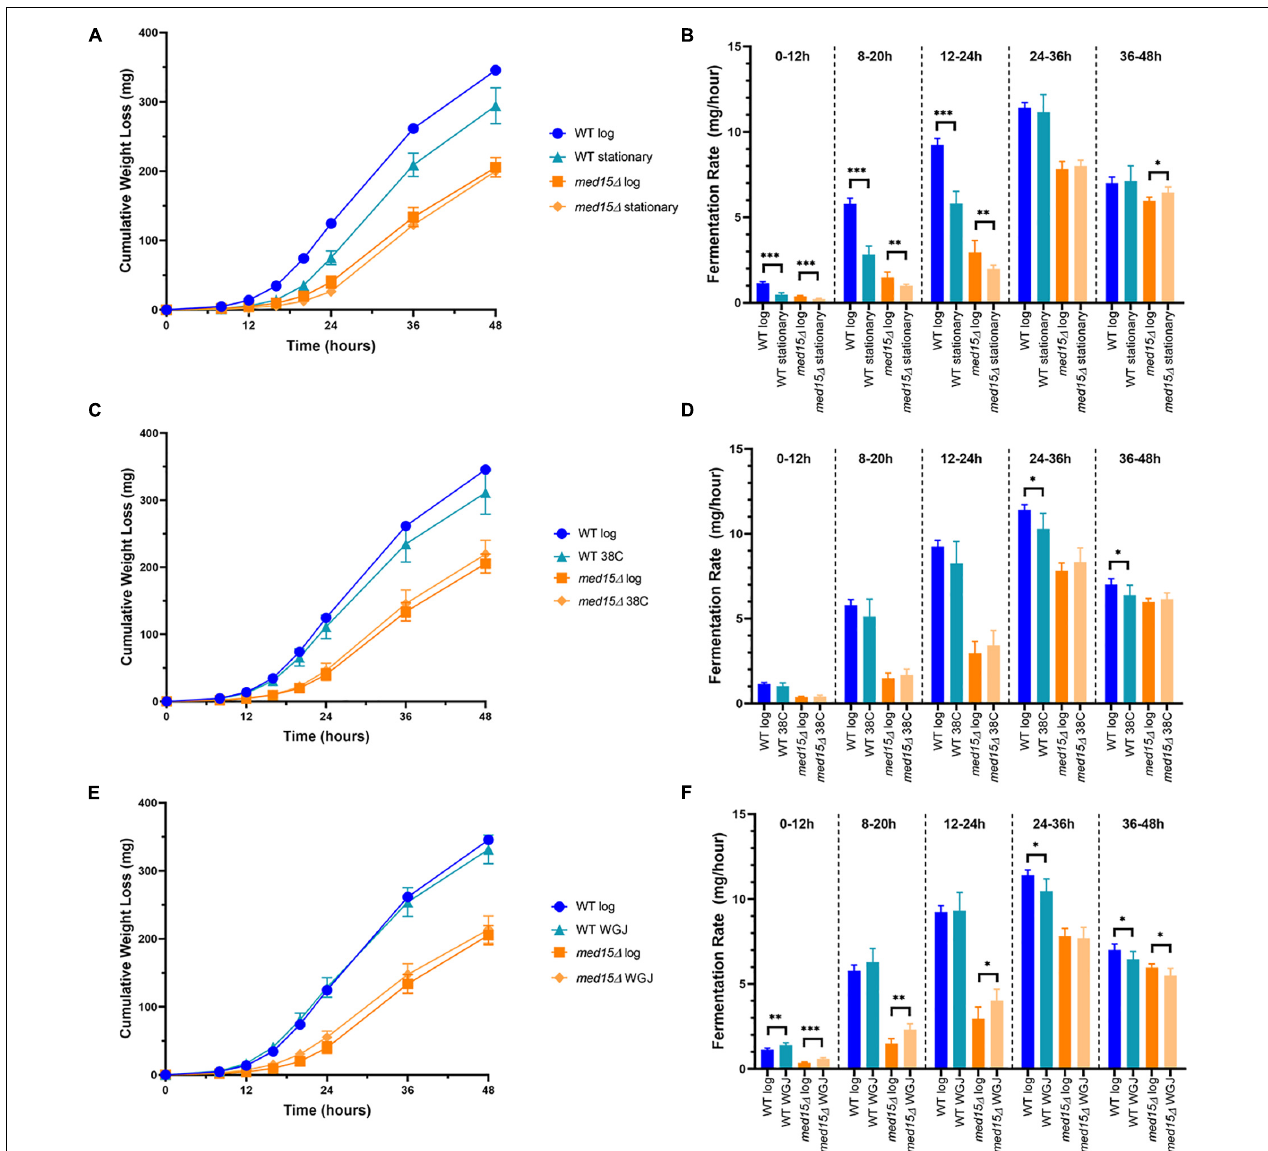
FIGURE 5 | Fermentation in the med15 mutant can be improved by related (same)-stress and cross-stress pre-treatments. (A,B) Log phase and stationary phase WT and med15 (cid:49) cultures were compared in a 6-day fermentation time course. Fermentation weight loss (A) and fermentation rate in 12-h time periods (B) . (C,D) The effect of cross-stress adaptation on fermentation rates was evaluated following a pre-treatment of log phase cells at 38 ◦ C. Fermentation weight loss (C) and fermentation rate in 12-h time periods (D) . (E,F) The effect of same-stress adaptation on fermentation rates was evaluated following pre-treatment of log phase cells with 1:3 WGJ:YPD media for 1 h. Fermentation weight loss (E) and fermentation rate in 12 h time periods (F) . Each data point is the average of 6 biological replicates and error bars reflect the standard deviation. The significance of differences between treated and untreated samples was determined using two-tailed t -tests. *, p ≤ 0.05; **, p ≤ 0.01; ***, p ≤